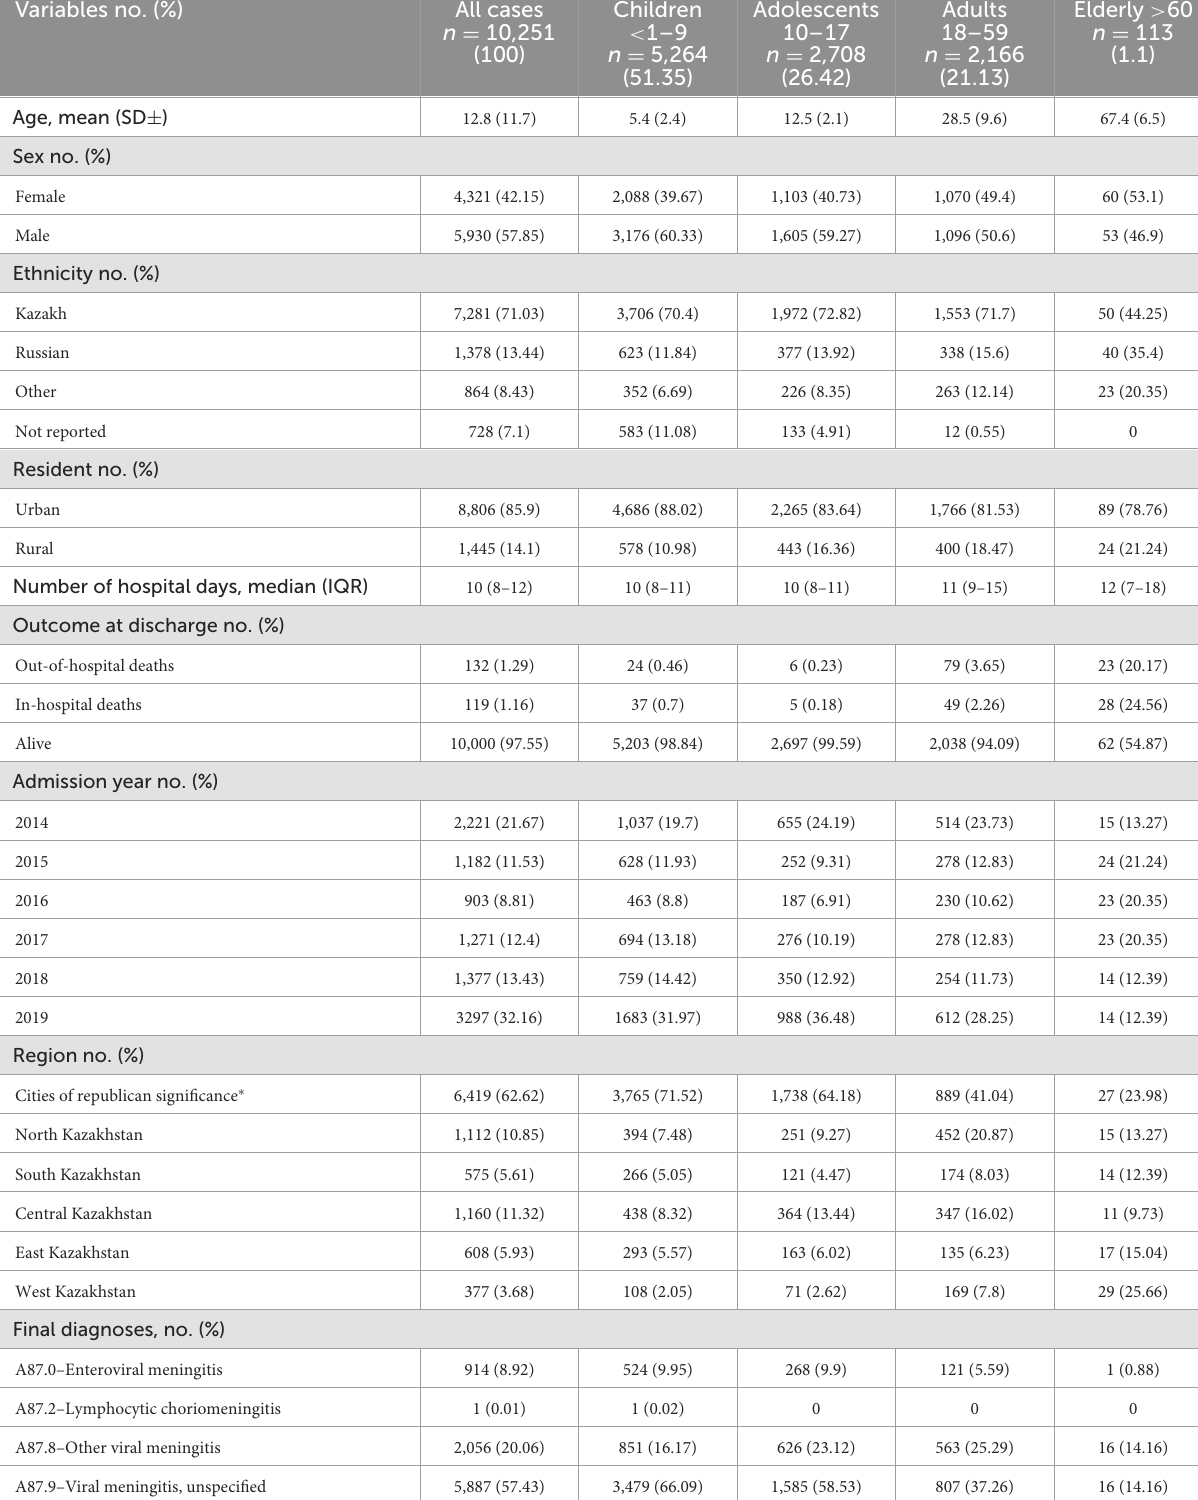
TABLE 1 Socio-demographic and disease-related variables for age categories of VM ( n = 10,251). Variables no.